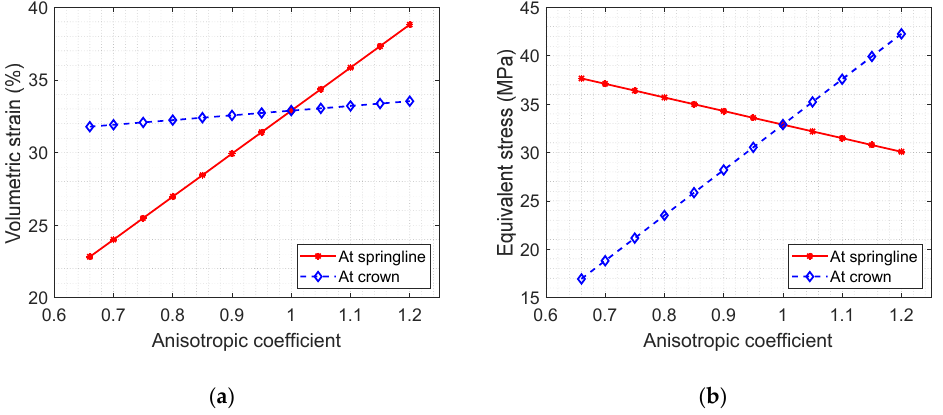
Figure 3. Evolution of volumetric strains in the outer flexible liner ( a ) and of equivalent stress in the concrete liner ( b ) at the springline and at the roof as function of the anisotropic coefficient of initial stress state.